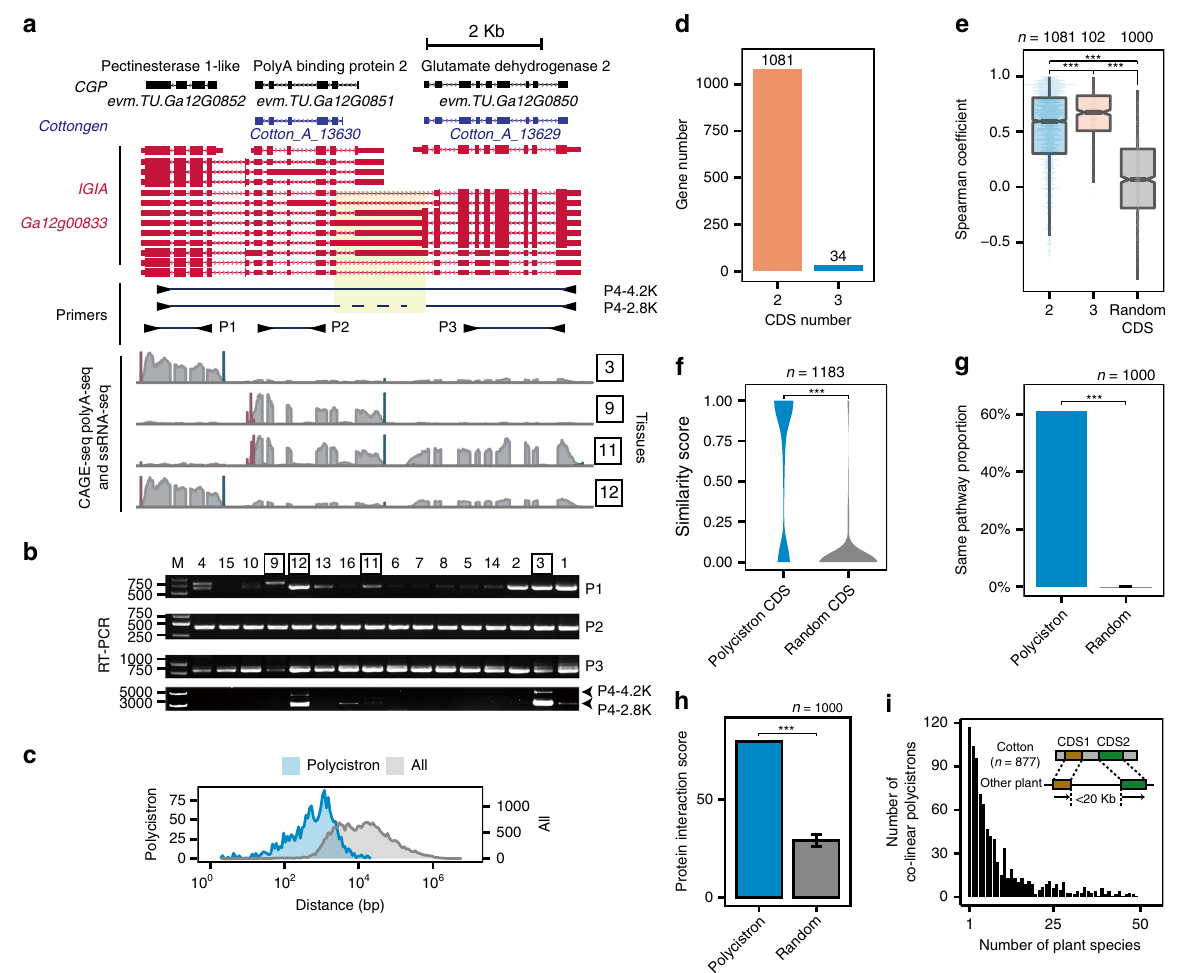
Fig. 5 Identi fi cation and genomic features of the polycistrons in G. arboreum . a An example of polycistron with three genes supported by the Pacbio long reads. The genes in the polycistron could be independently transcribed and have independent TSSs and TESs. The probes for RT-PCR validation of the polycistron expression are marked below IGIA transcripts. b RT-PCR validation of polycistron transcripts from transcriptional read-through. Four pairs of probes are indicated. c Statistics of the distances between CDS pairs in a polycistron compared with the distances between a CDS and its closest CDS in IGIA genes. d The number of polycistrons with two and three CDSs identi fi ed using IGIA genes. e Expression correlation between CDS pairs in a polycistron and random CDS pairs. f – h Comparison of GO similarity ( f ), proportion in the same KEGG pathway ( g ), and potential protein – protein interactions ( h ) between CDS pairs in a polycistron and random CDS pairs. i Co-linear analysis of cotton polycistrons in 54 plant genomes. The signi fi cance levels are indicated by asterisks (* p -value< 0.05; ** p -value<0.01; *** p -value<0.001), and error bar represents s.d. value. The source data underlying Fig. 5b and 5f – i are provided as a Source Data fi